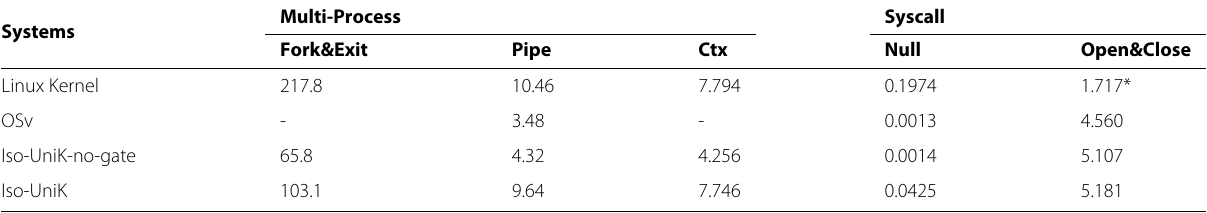
Table 3 The mean latency (in μ s or microseconds) of some important multi-process interfaces and syscalls evaluating with lmbench